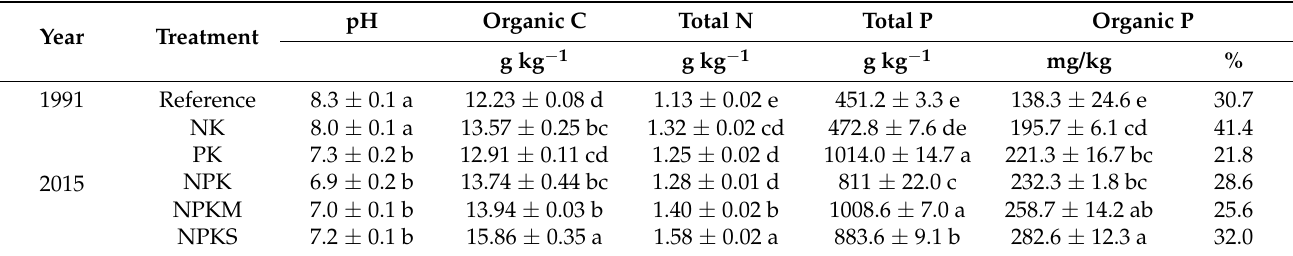
Table 1. Selected properties of the studied soil